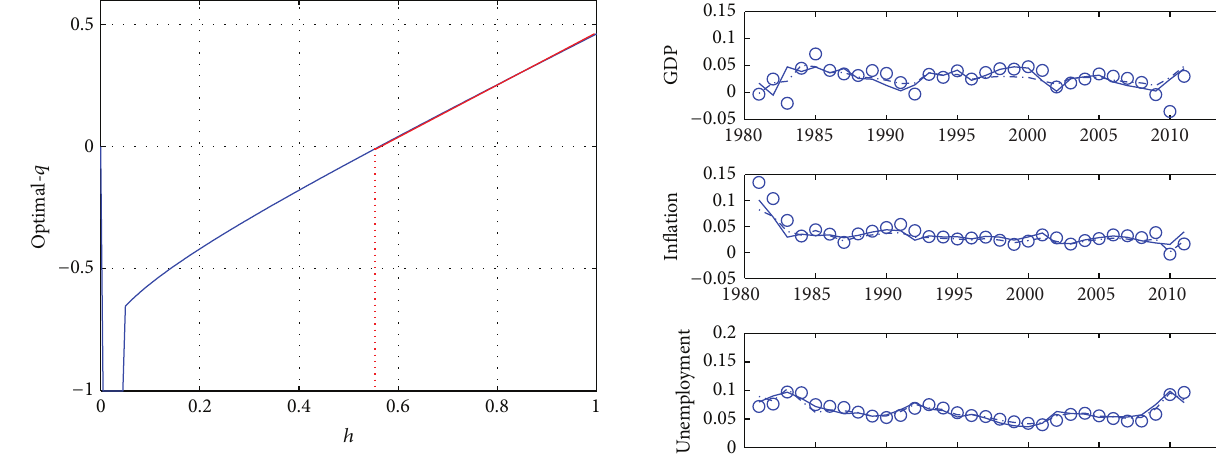
nonlinear fractional dynamical system. The percent change of GDP, average consumer prices percent change rate, unem- ployment rate percent of total labor force are used to reflect the variables GDP, inflation, and unemployment, respectively.